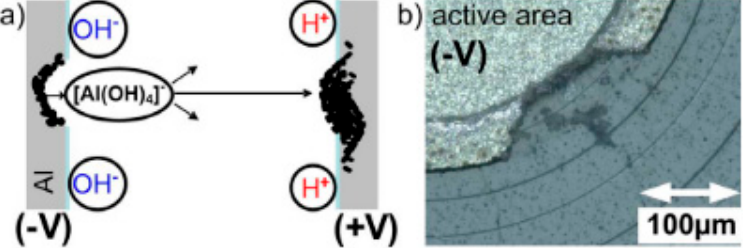
Figure 6. Schematic process of aluminum corrosion and accumulation ( a ). An example of an eroded metallization edge on the junction termination of a diode chip after HV-THB testing ( b ). Figure reproduced with permission from [9].